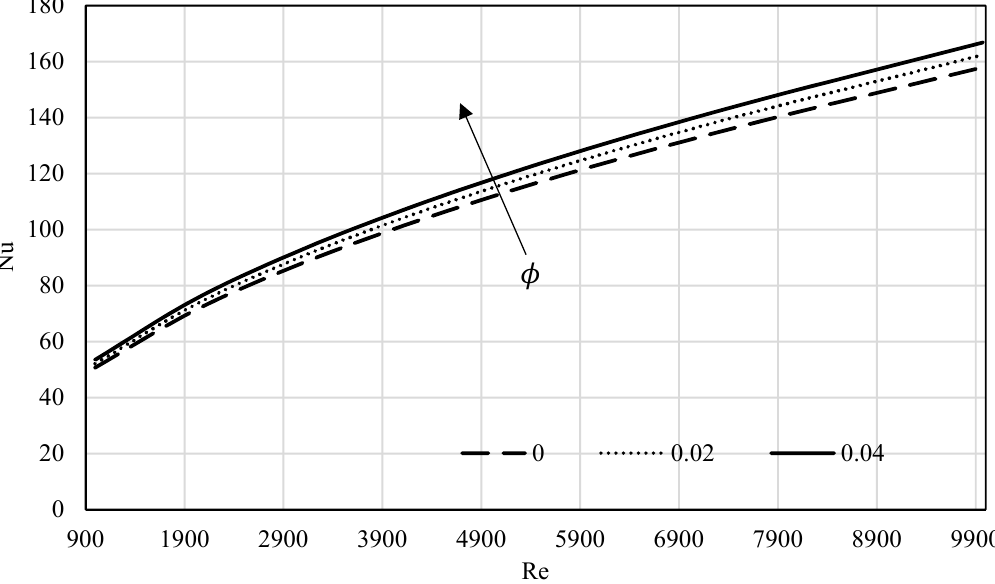
Figure 15. Variation of Nusselt number versus the Reynolds number ( Re ) for Al 2 O 3 –water.